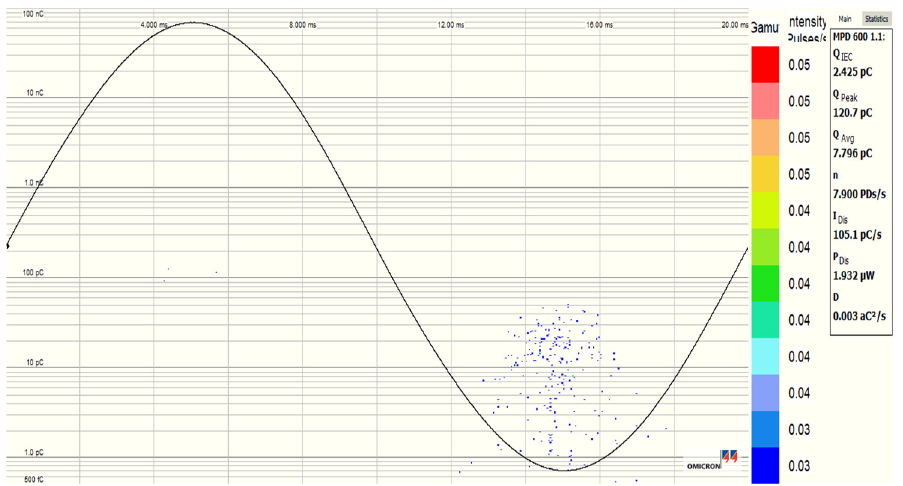
Figure 21. PD pattern of synthetic ester-based NF with Fe 3 O 4 (20 nm, 0.4 g/L) at 13 kV (RMS) voltage level.